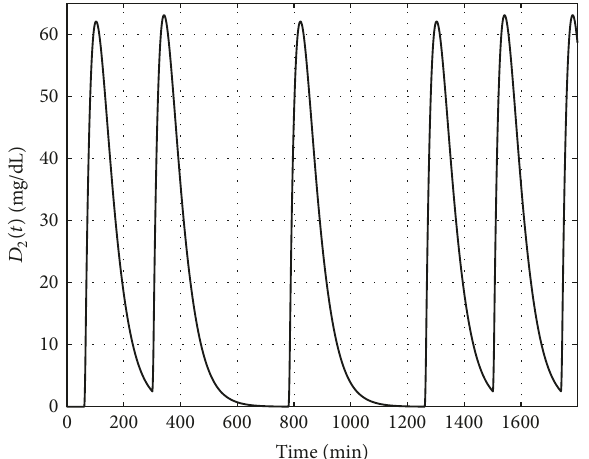
Figure 5: Variation of the first state of the insulin absorption subsystem.